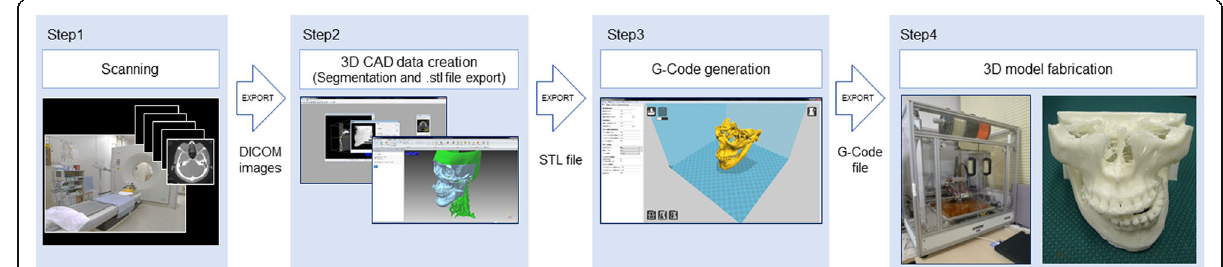
Fig. 1 Process workflow for 3D model fabrication using desktop 3D printers. (Step 1) MDCT scanning. (Step 2) Open in medical image processing software “ Volume Extractor 3.0 ” and polygon data editing software “ POLYGONALmeister ” to check, create, and adjust the 3D CAD model. (Step 3)